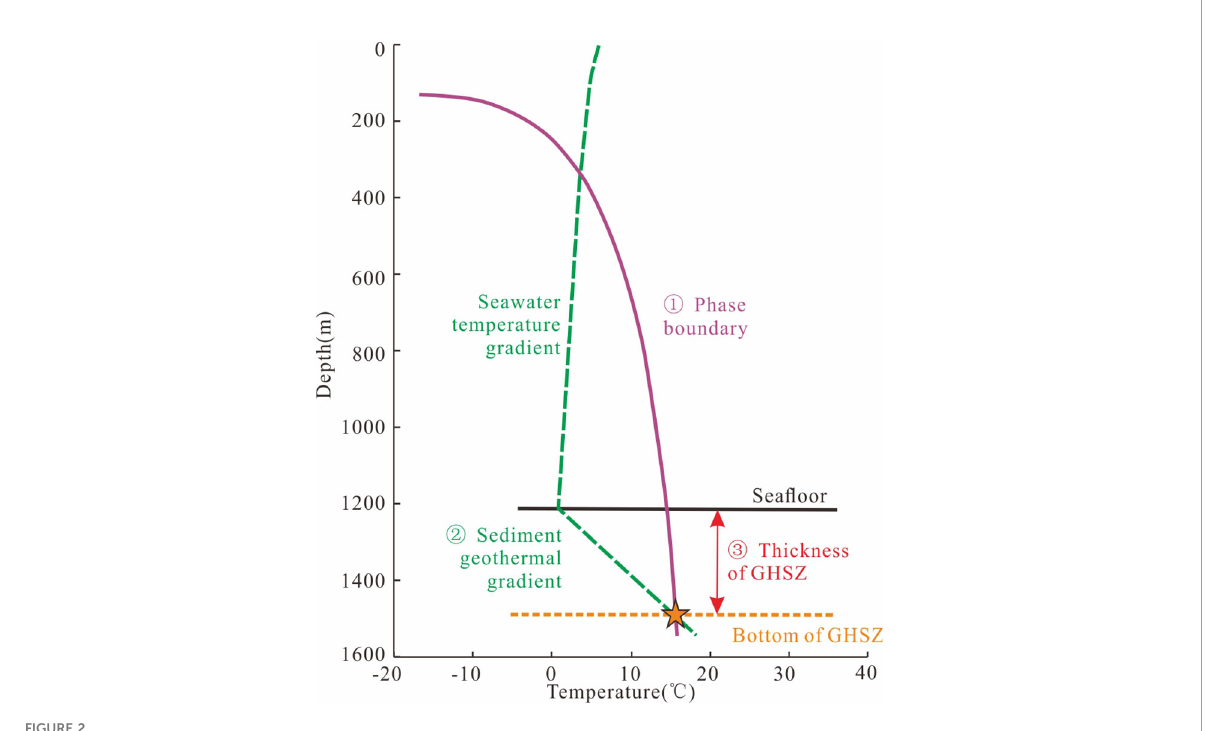
FIGURE 2 Calculation diagram of the GHSZ thickness controlled by ocean temperature (T) and pressure